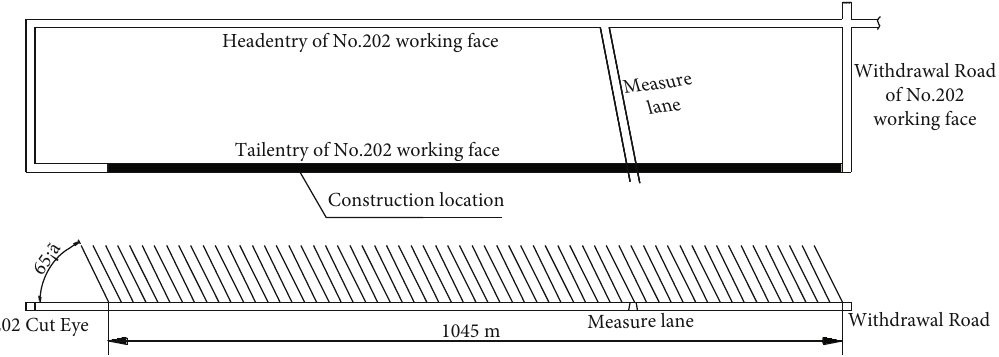
Figure 13: Drilling plan